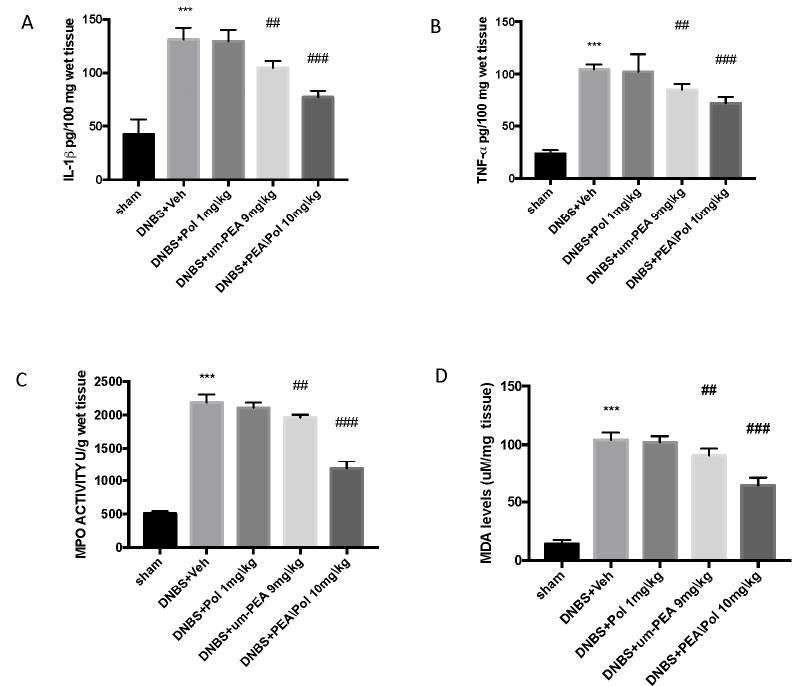
Figure 3. The effects of PEA/Pol on cytokine, myeloperoxidase (MPO) activity, and malondialdehyde (MDA) levels. IL-1 β ( A ), TNF- α ( B ), MPO ( C ), and MDA ( D ) levels were examined. PEA/Pol treatment reduces cytokines, MPO activity, and MDA levels. Values = means ± SEM of six animals in each group; *** p < 0.001 vs. sham; ## p < 0.01 vs. DNBS. ### p < 0.001 vs. DNBS.